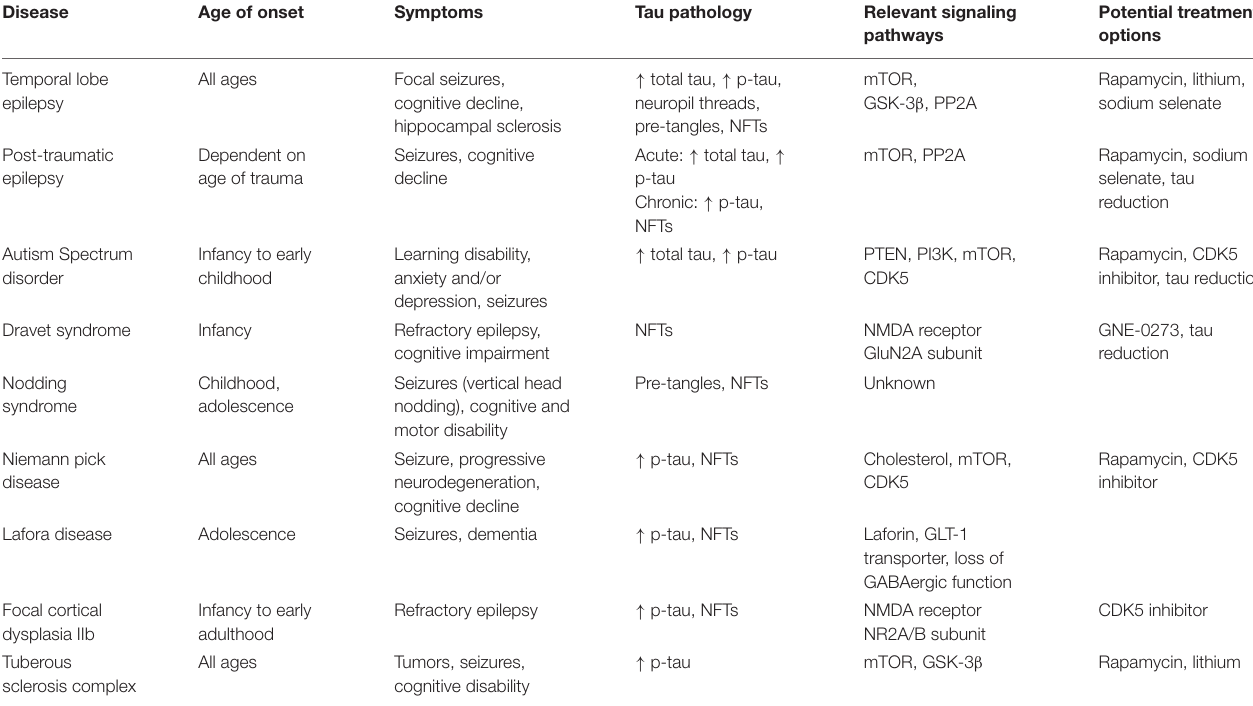
FIGURE 3 | Interplay of endogenous tau, mTOR, and autophagy in epilepsy. (A) Under normal physiological conditions (blue), endogenous tau positively regulates mTOR activity via PTEN inhibition, and mTOR in turn negatively regulates autophagy mechanisms that contribute to the clearance of tau and p-tau. (B) In hyperexcitability states found in pathophysiological conditions such as tuberous sclerosis complex and Niemann-Pick type C disease (red), overactivation of mTOR due to increased PTEN inhibition causes excess inhibition of autophagy, resulting in reduced clearance of tau species. Elevated levels of normal tau in turn exacerbate epileptic activity and mTOR disinhibition. PTEN, phosphatase and tensin homolog deleted chromosome 10; mTOR, mammalian target of rapamycin; p-tau, phosphorylated tau. Created with BioRender.com. TABLE 1 | Characterization of seizure disorders and their links to tau pathology and tau-associated